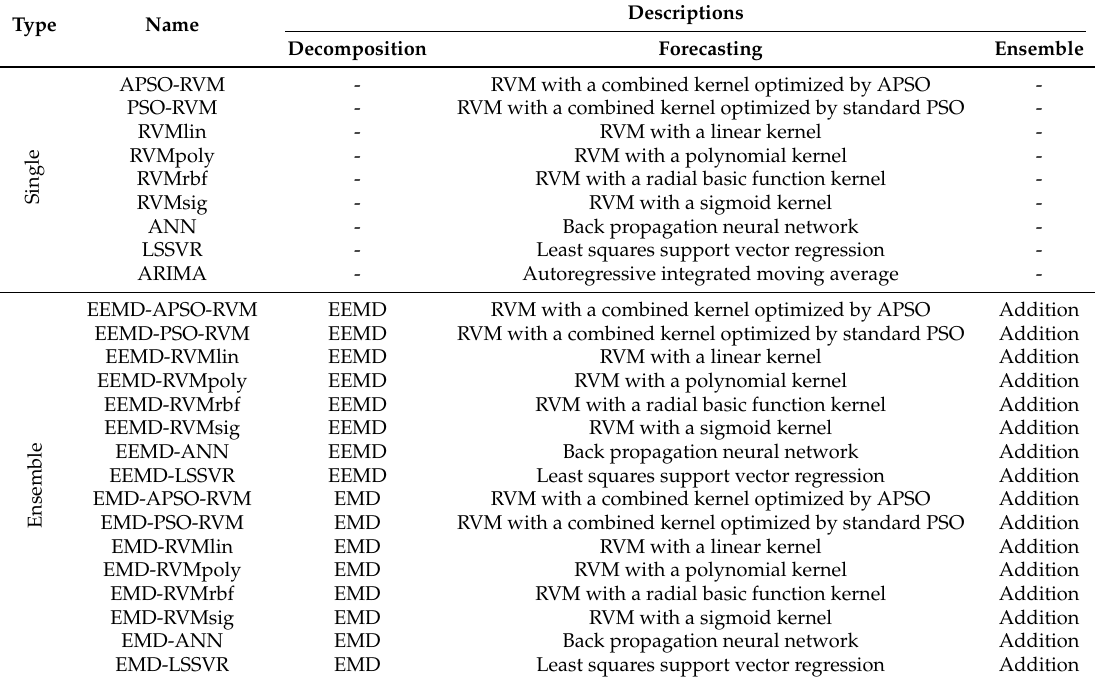
Table 1. Descriptions of all the methods in the experiments. ANN: artificial neural network; PSO: particle swarm optimization.